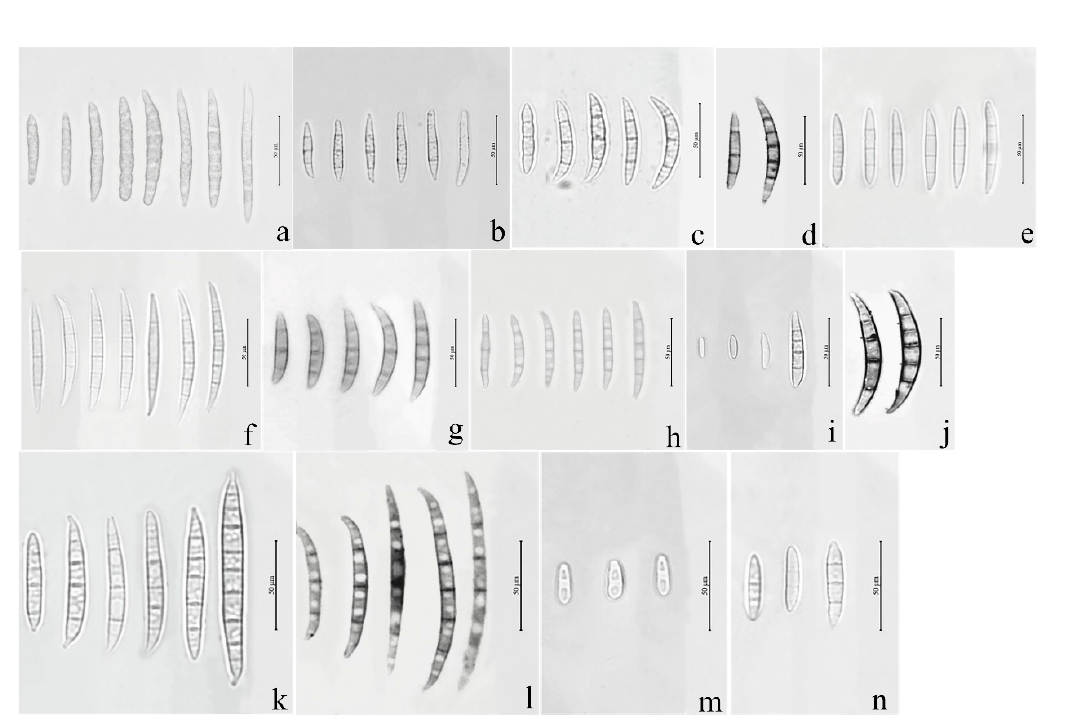
a Percentage = n /N × 100%, where n is the number of isolates for one species of Fusarium, and N is the total number of isolates for all Fusarium species.